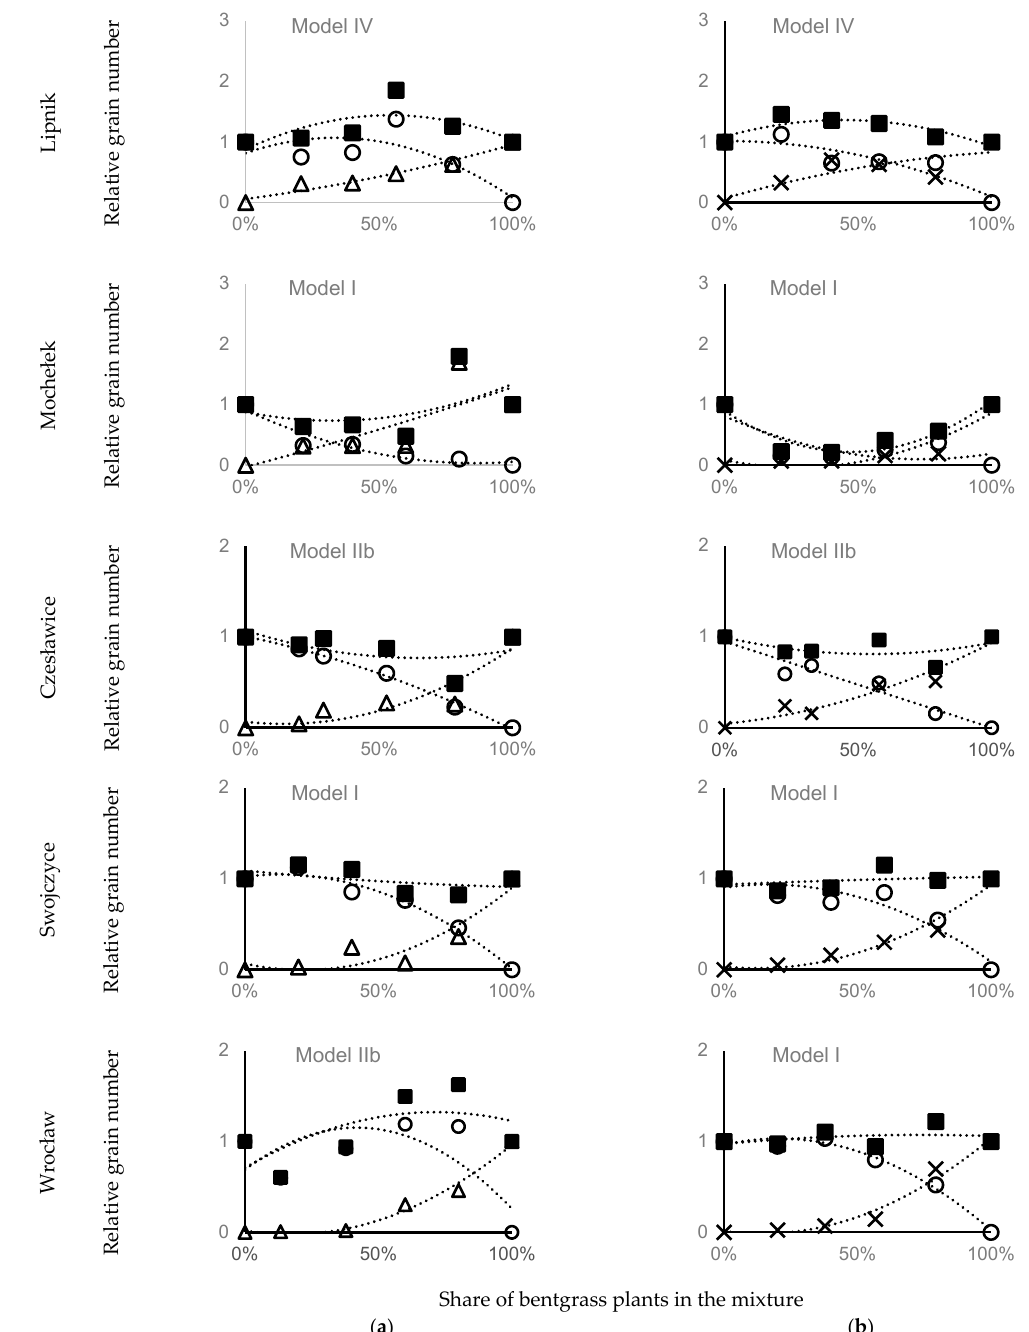
Figure 3. The substitutive competition model for the relative number of grains per plant of winter wheat (WW) and bentgrass in the 2017–2018 season, classified according to the t -test and p -values < 0.05. ( a ) Competition between WW and bentgrass with a single resistance to piroxulam (RS), and ( b ) competition between WW and herbicide-susceptible bent- grass (S). Legend: ○ —WW; Δ —RS; × —S; □ —RS + WW ( a ) or S + WW ( b ).